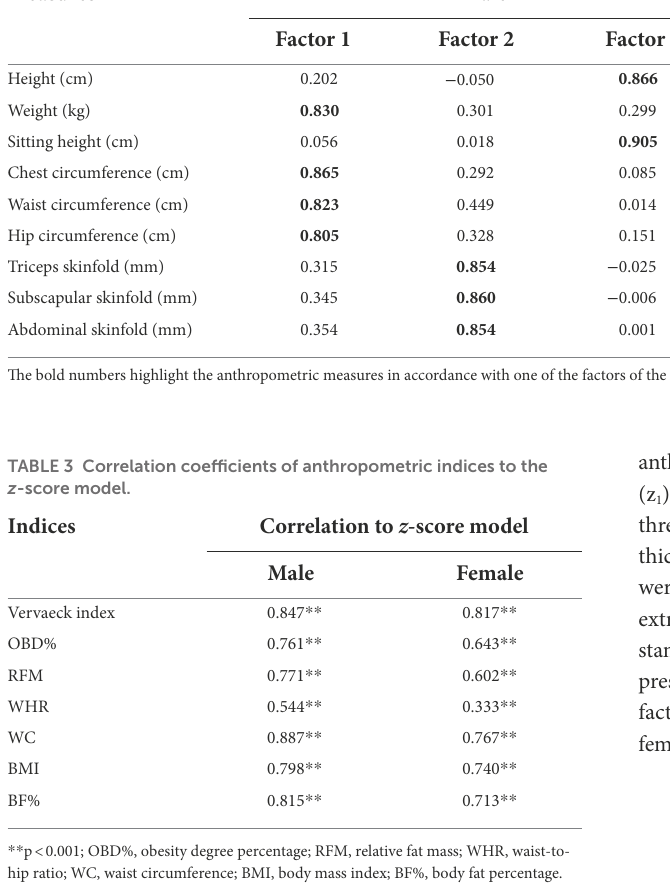
TABLE 2 Rotated factor loading of the anthropometric measures. Measures